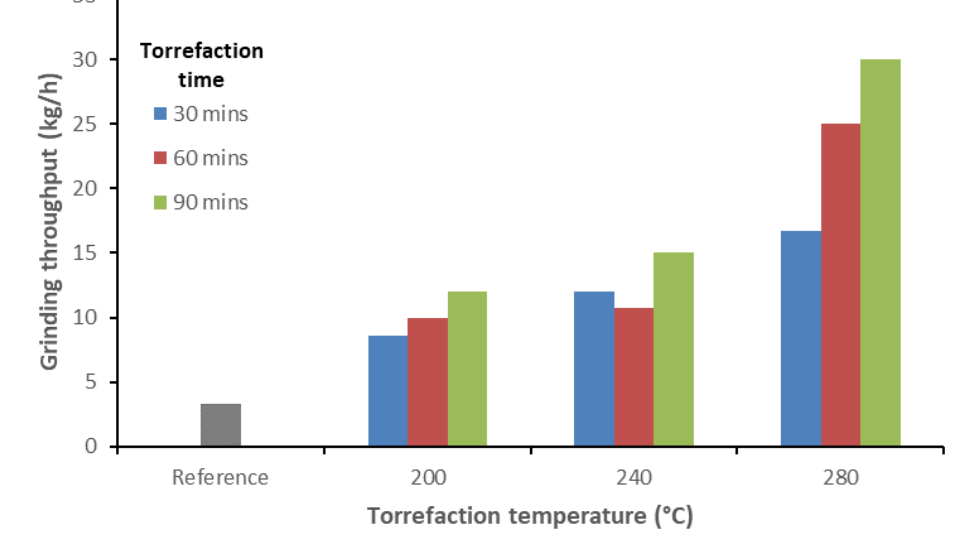
Figure 4. Grinding throughput of raw and torrefied corncobs.